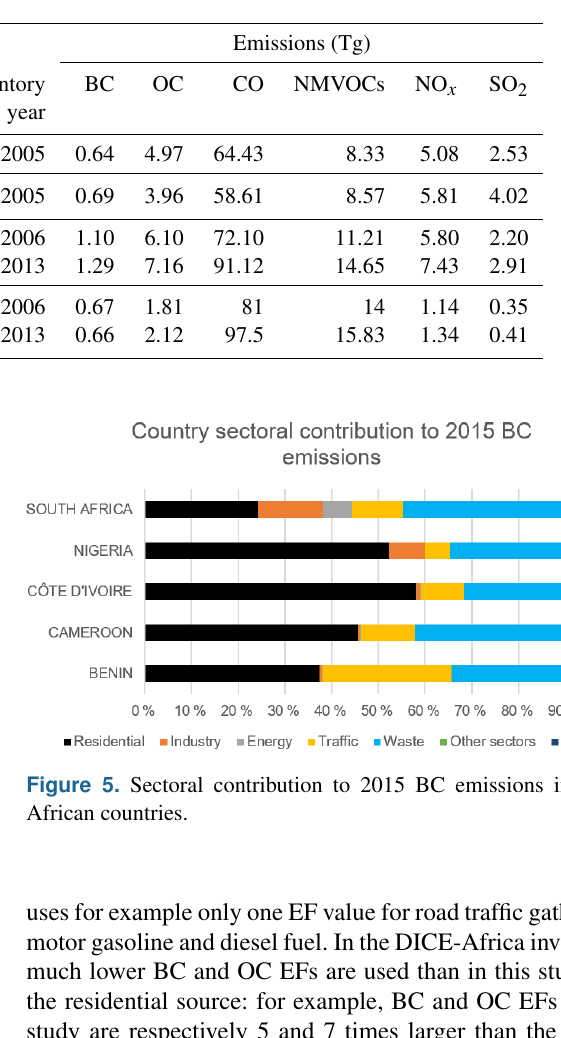
Table 3. Comparison of fossil fuel and biofuel emissions between this work, Liousse et al. (2014), and Marais and Wiedinmyer (2016) inventories for the year 2005, 2006 and 2013.